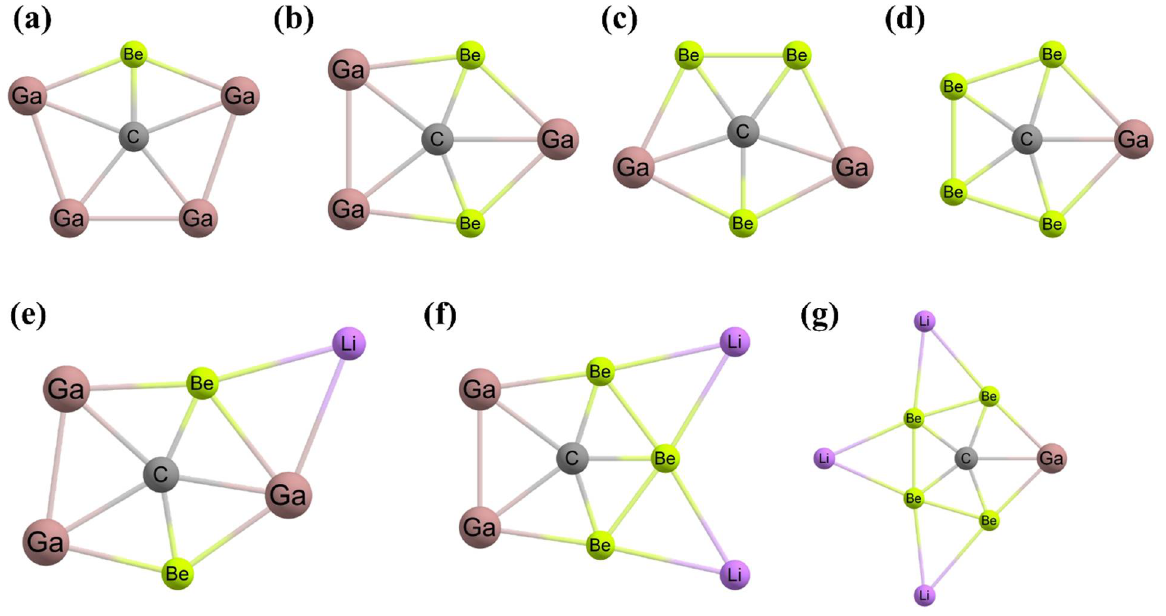
Figure 25. The lowest-energy ppC forms for ( a ) CGa 4 Be, ( b ) CGa 3 Be 2− , ( c ) CGa 2 Be 32− , ( d ) CGaBe 43− , ( e ) CGa 3 Be 2 Li, ( f ) CGa 2 Be 3 Li 2 , and ( g ) CGaBe 4 Li 3 clusters.